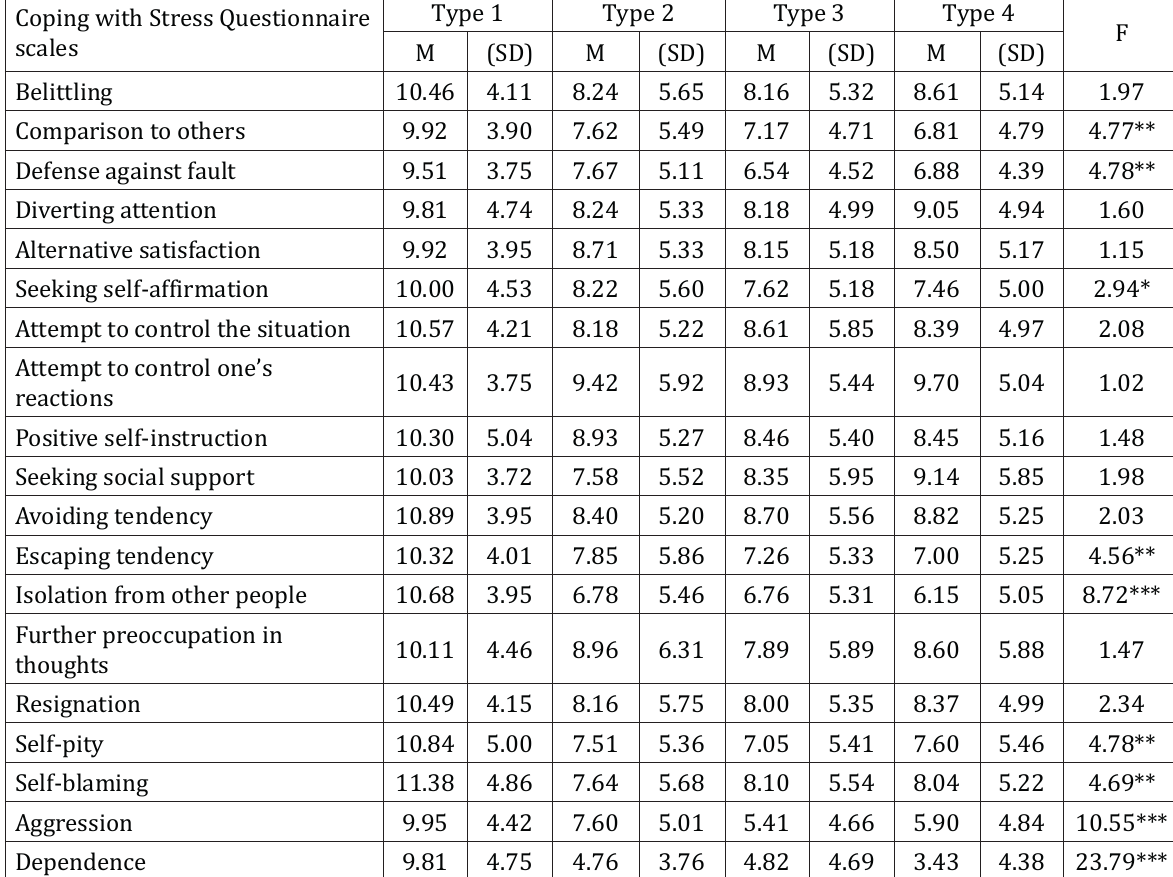
Table 2. Mean scores obtained by the four groups (types) of gamers on SVF scales